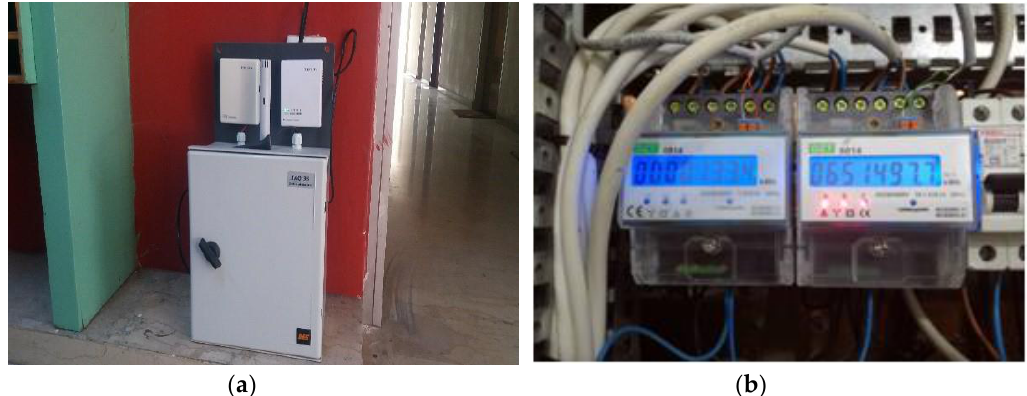
Figure 2. Experimental equipment for measurements of ( a ) IEQ and ( b ) electrical consumption within the building of B FEPA.